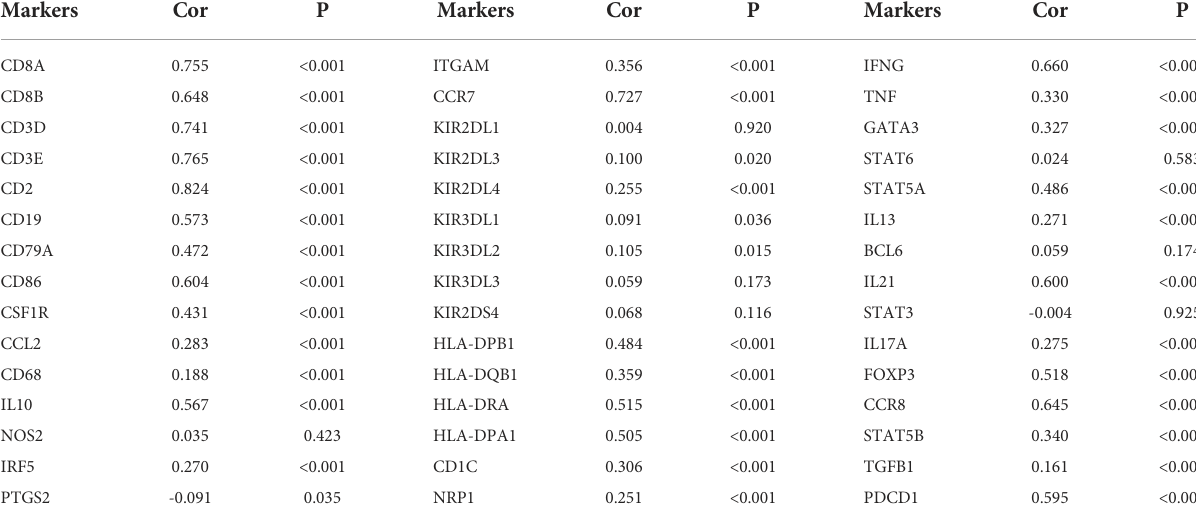
TABLE 3 Correlation between TRAT1 expression and expression levels of immune cell markers in